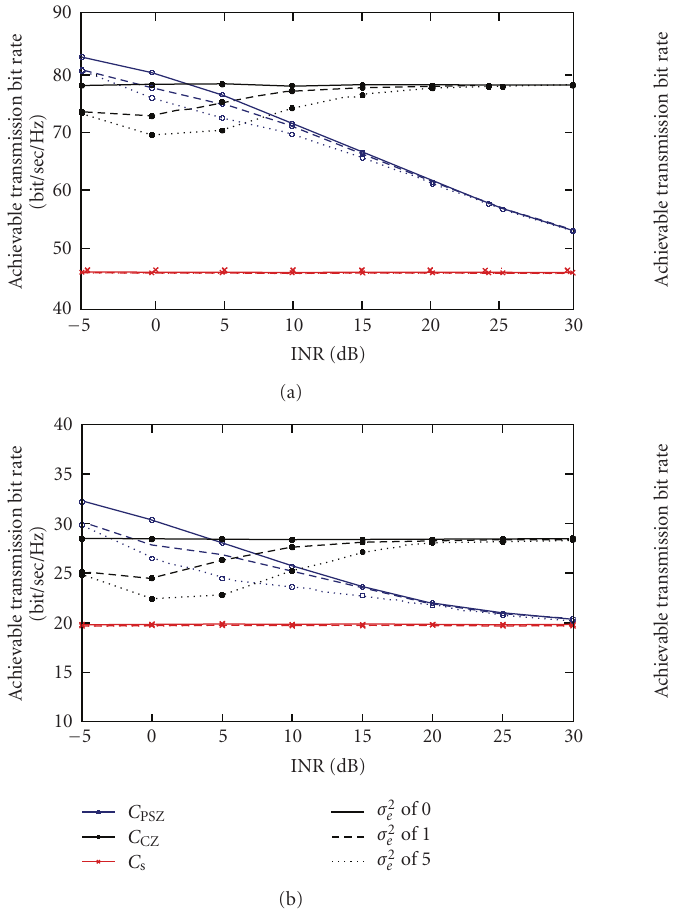
Figure 6: Median value of achievable transmission bit rate versus INR for 8 × 2 MIMO systems (a) when SNR is 30 dB and (b) when SNR is